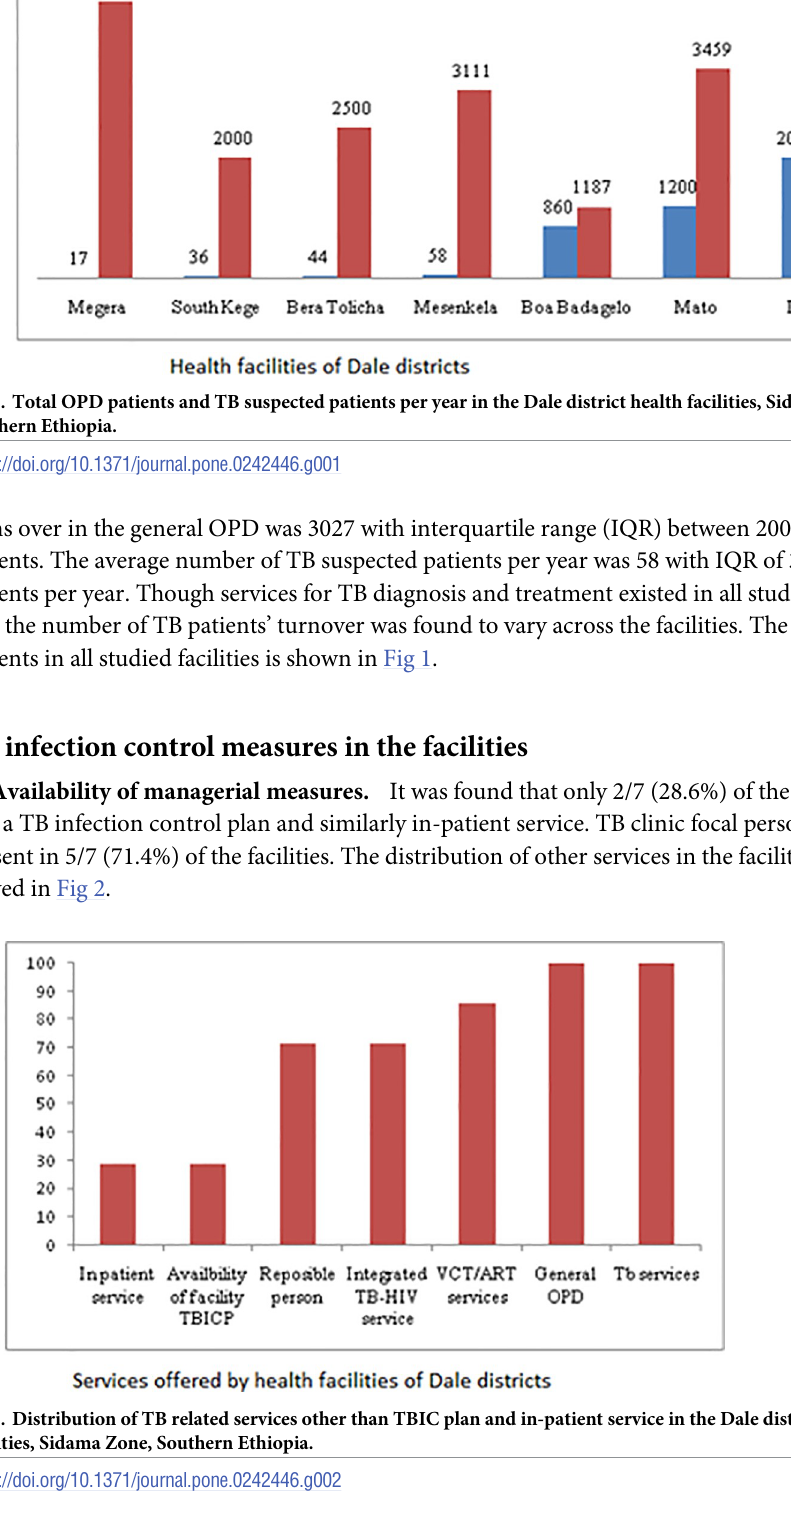
PLOS ONE | https://doi.org/10.1371/journal.pone.0242446 October 12,